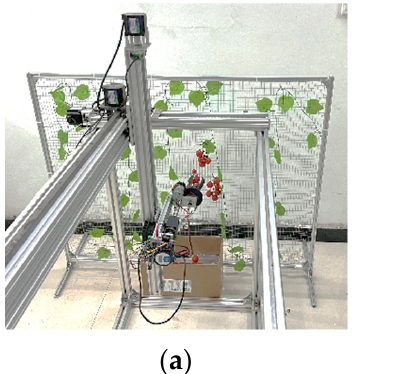
Table 4. Results of picking